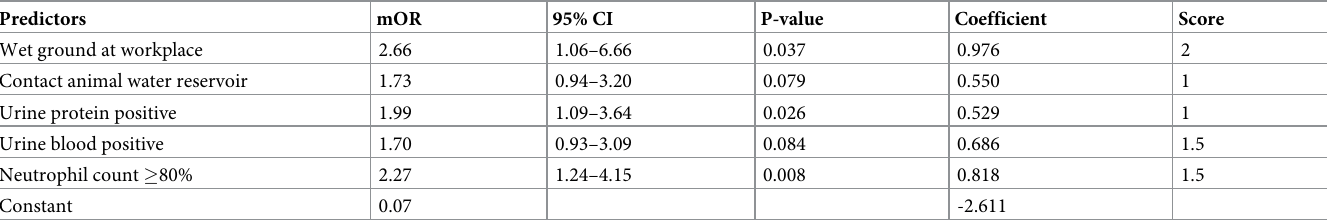
Table 3. Multivariable logistic model with score transformation via weighing of logit coefficients.